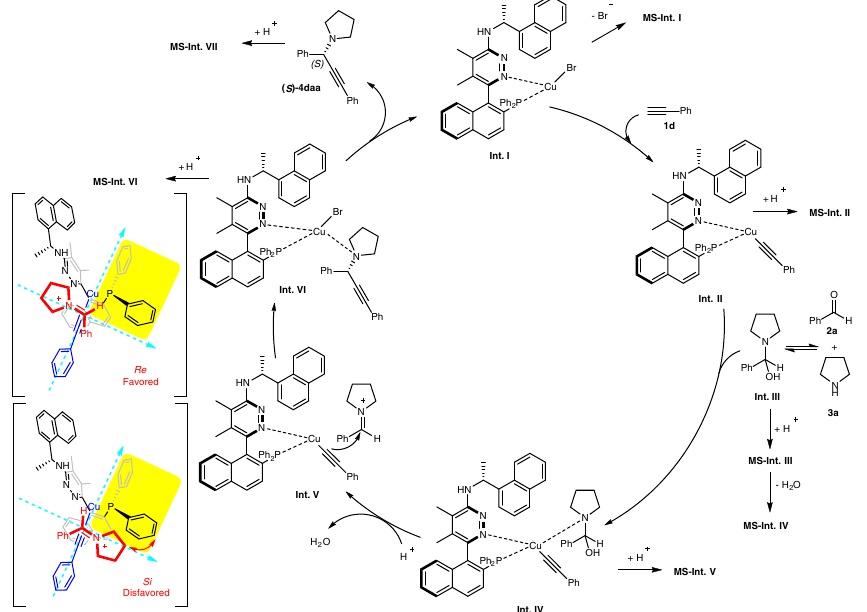
Fig. 6 A proposed mechanism of the current A 3 -coupling reaction. A mechanism involving a monomeric copper(I) complex bearing a single chiral ligand was proposed under the instruction of the SAESI-MS